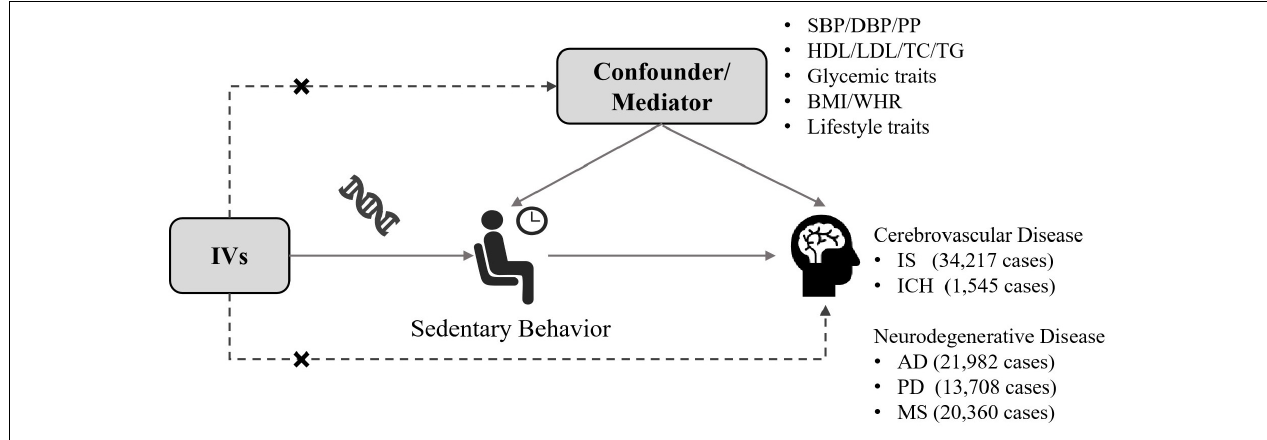
FIGURE 1 | Conceptual schematic of the two-sample Mendelian randomization for the association between sedentary behavior and the risks of cerebrovascular diseases and neurodegenerative diseases. IV, instrumental variable; IS, ischemic stroke; ICH, intracerebral hemorrhage; AD, Alzheimer’s disease; PD, Parkinson’s disease; MS, multiple sclerosis; SBP, systolic blood pressure; DBP, diastolic blood pressure; PP, pulse pressure; HDL, high-density lipoprotein; LDL, low-density lipoprotein; TC, total cholesterol; TG, triglyceride; BMI, body mass index; WHR, waist-to-hip